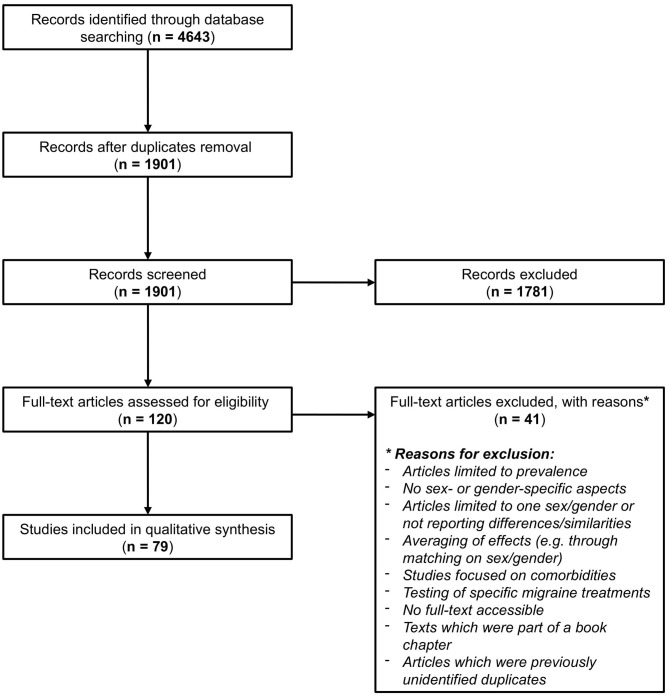
Flowchart of the review process, modified from PRISMA 2009 Flow Diagram (19).